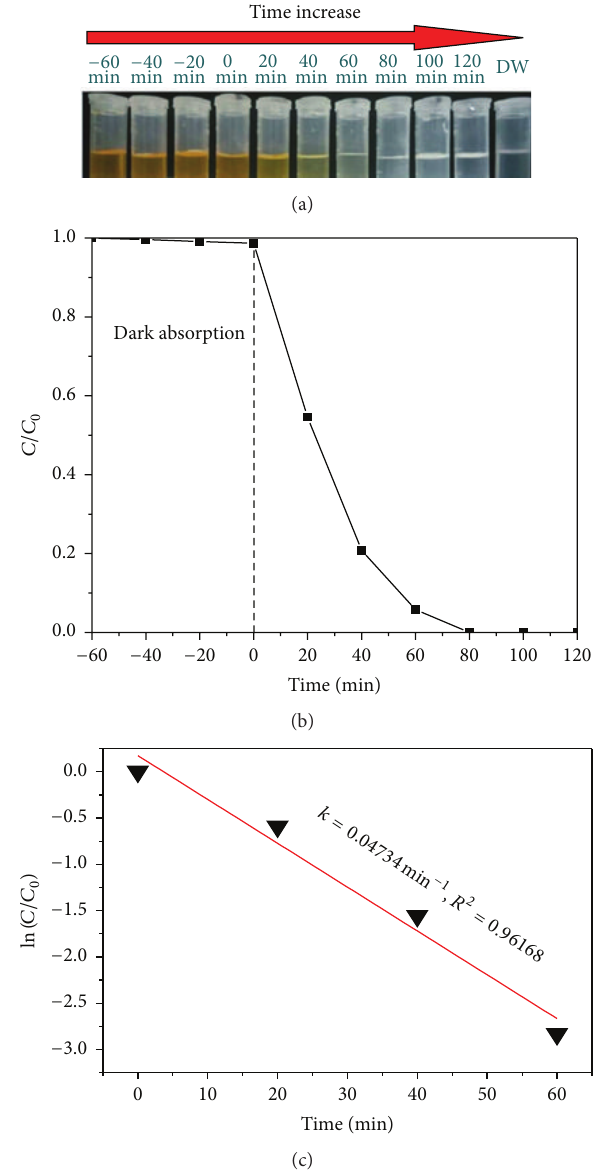
Figure 5: (a) Photographs of MO under UV irradiation at different times, (b) liquid-phase photocatalytic degradation of MO under the irradiation of UV light, and (c) kinetics of photocatalytic deg- radation of MO under UV for filter paper inspired zinc oxide